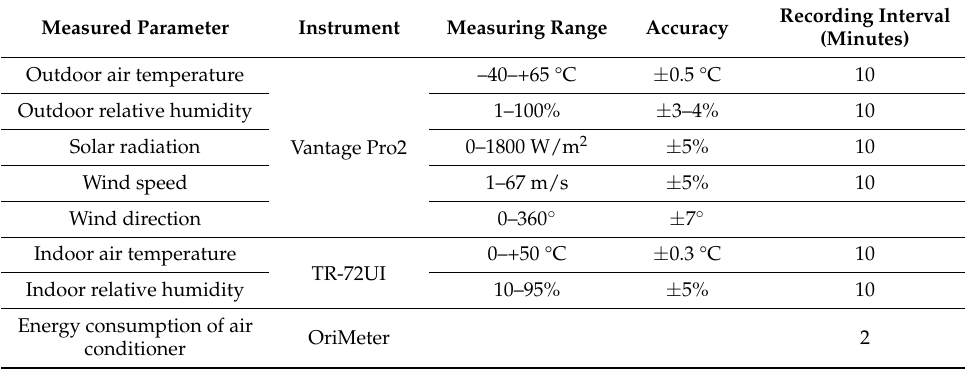
Table 2. Key parameters of the measuring instruments.